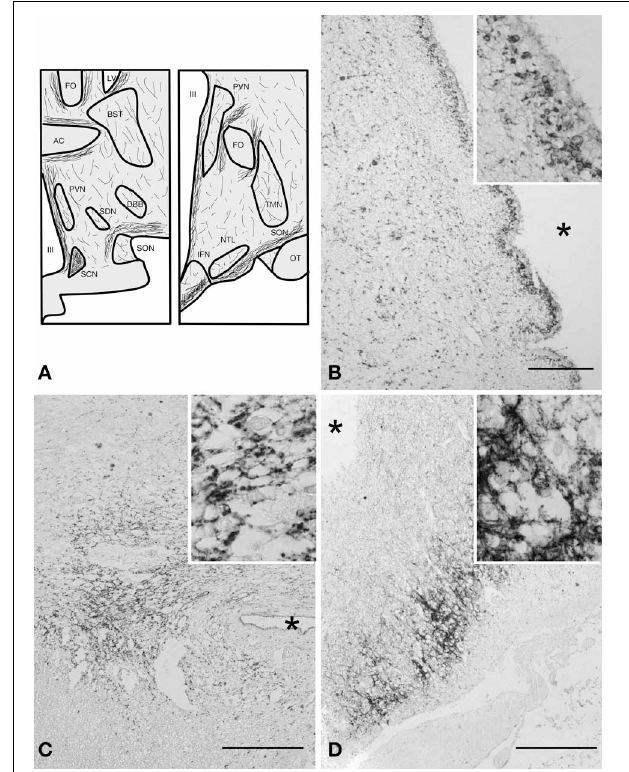
FIGURE 1 | (A) Schematic illustration of the distribution of immunoreactive serotonin transporter (SERT) fibers in coronal sections (rostral and caudal) of the human hypothalamus. Abbreviations: AC, anterior commissure; BST, bed nucleus of the striae terminalis; DBB, diagonal band of Broca; FO, fornix; IFN, infundibular nucleus; LV, lateral ventricle; NTL, lateral tuberal nucleus; OT, optic tract; PVN, paraventricular nucleus; SCN, suprachiasmatic nucleus; SDN, sexually dimorphic nucleus; SON, supraoptic nucleus; TMN, tuberomamillary nucleus; III, third ventricle. (B) SERT staining, ependymal layer at the level of the PVN bar = 100 μ m, (C) suprachiasmatic nucleus, bar = 250 μ m, (D) infundibular nucleus, bar = 500 μ m. ∗ Indicates the third ventricle. High power inserts are from the same anatomical